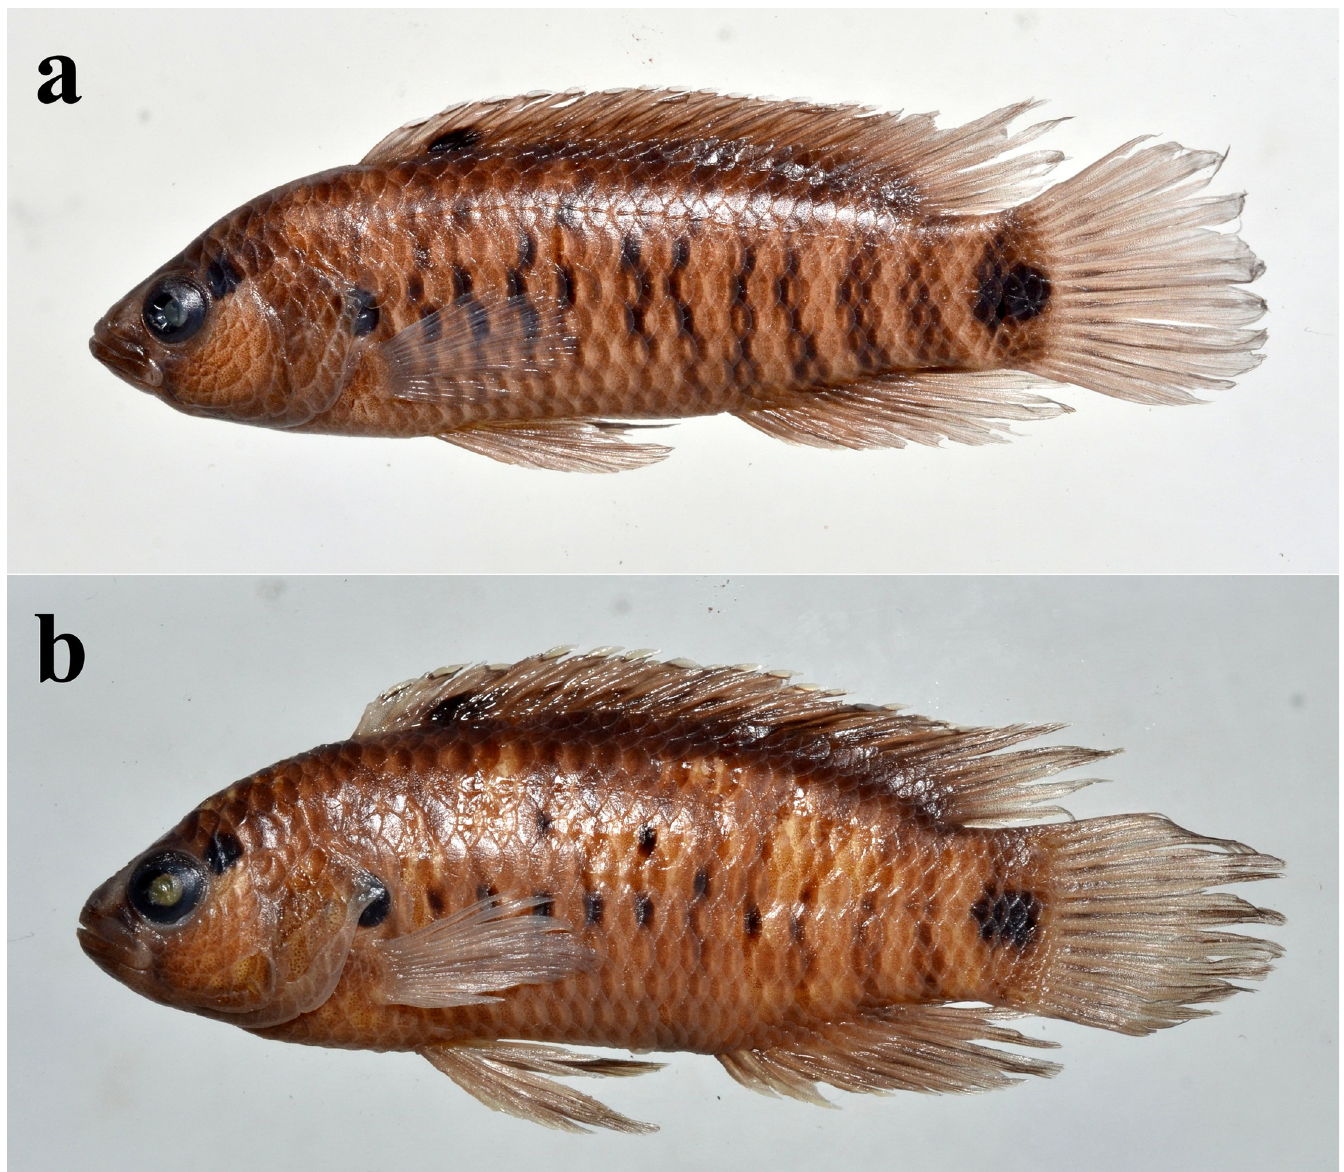
Fig 3. a) Badis kaladanensis , holotype, ZSI FF 5404, 48.6 mm SL; b) Paratype, PUCMF 15002, 45.2 mm